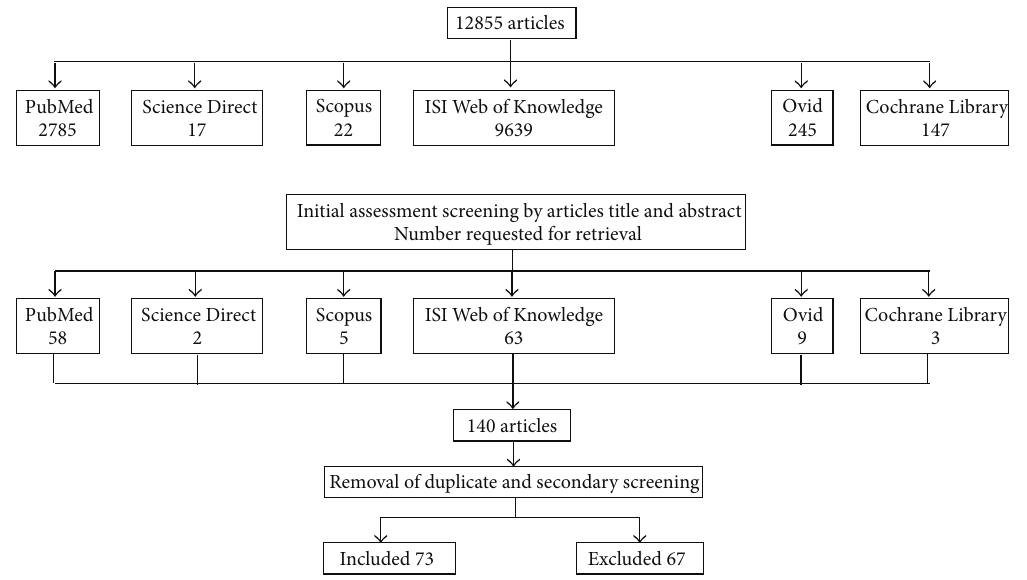
Figure 1: Literature search and retrieval